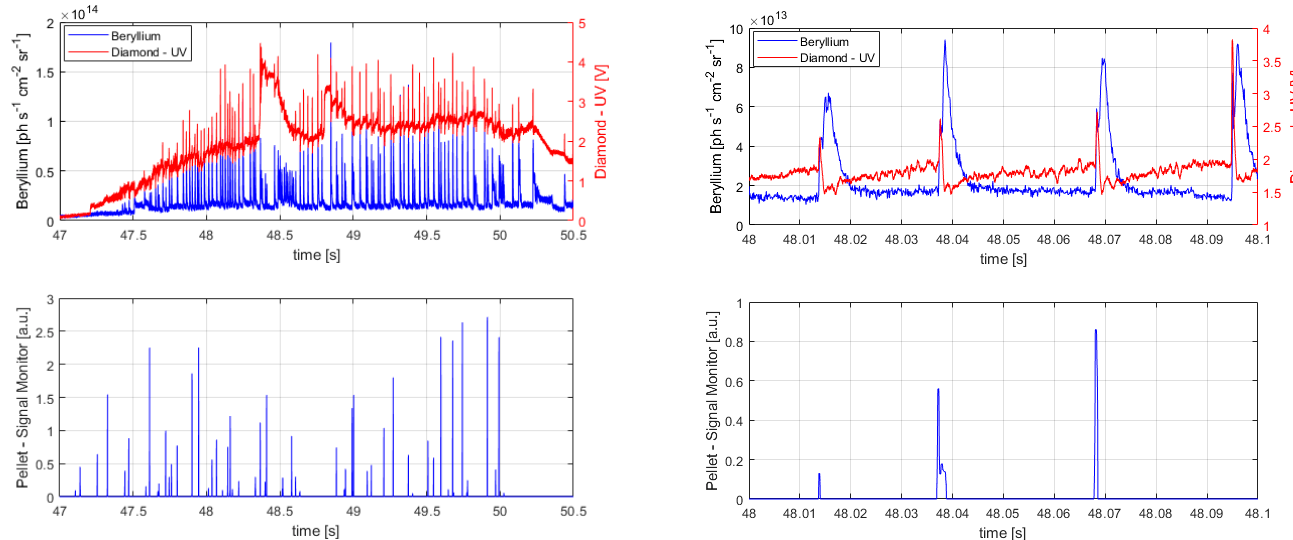
Figure 2. Shot 92238. In the first column, the ELM signals ( top plot, beryllium in blue and diamond UV in red) and the pellet signal ( bottom plot) are shown along the discharge (then, plasma disrupts). Second column shows a detail of the same signals for 48.0 s < t < 48.1 s.